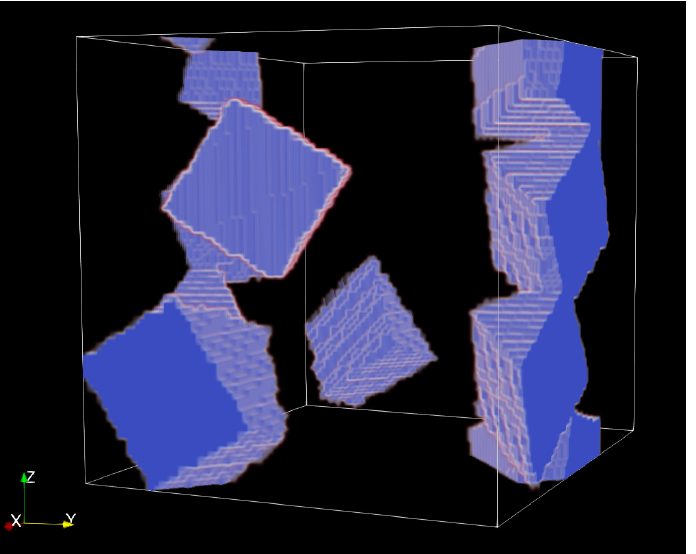
Figure 4. Three-dimensional geometrical domain composed of solid, cubical grains (blue) and fluid region (void). Fluid inlet is at the bottom of the domain while outlet is at the top with a pressure gradient in positive z direction. Periodic boundary conditions are in other ( x and y )